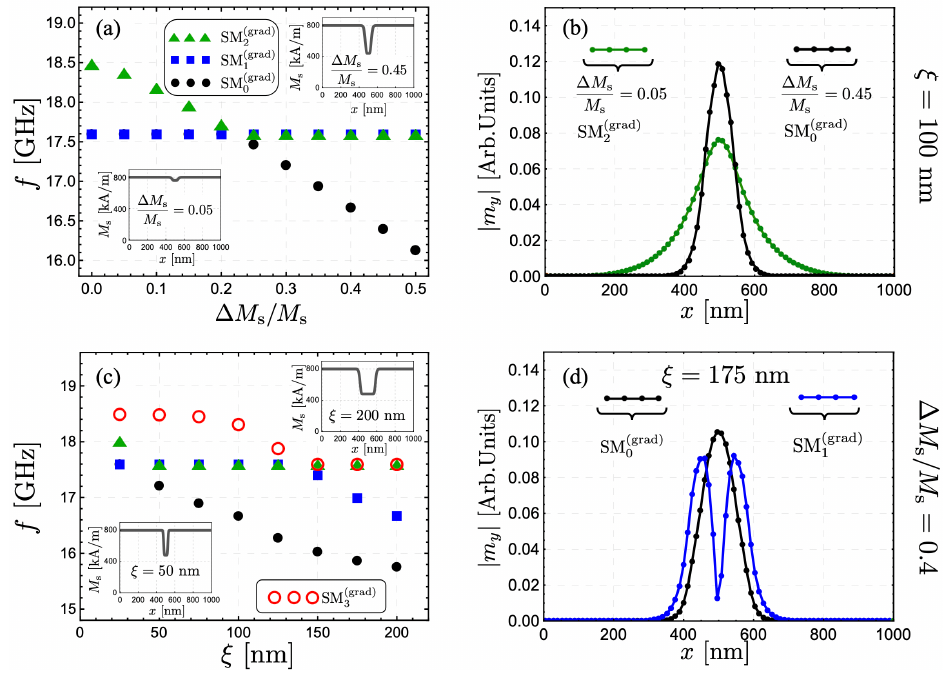
( grad ) = 0, 1 and 2) as a function of ∆ M s / M s . The modes are Figure 5. ( a ) Modes SM ν (with ν evaluated at k z = 0 and ξ = 100 nm, for a wider strip with w = 1000 nm. The crossing between modes reveals the weak coupling caused by the larger strip width w . The absolute value of the normal magnetization component for ∆ M s / M s = 0.05 and 0.45 is illustrated in ( b ) for modes SM ( grad ) ( grad ) = 0, 1, 2 and 3) as a function of ξ . The case k z = 0, SM , respectively. ( c ) Modes SM ν (with ν 0 ∆ M s / M s = 0.4, and w = 1000 nm is considered. The magnetization profiles of modes SM ( grad ) SM are shown in ( d ) for ξ = 175 1